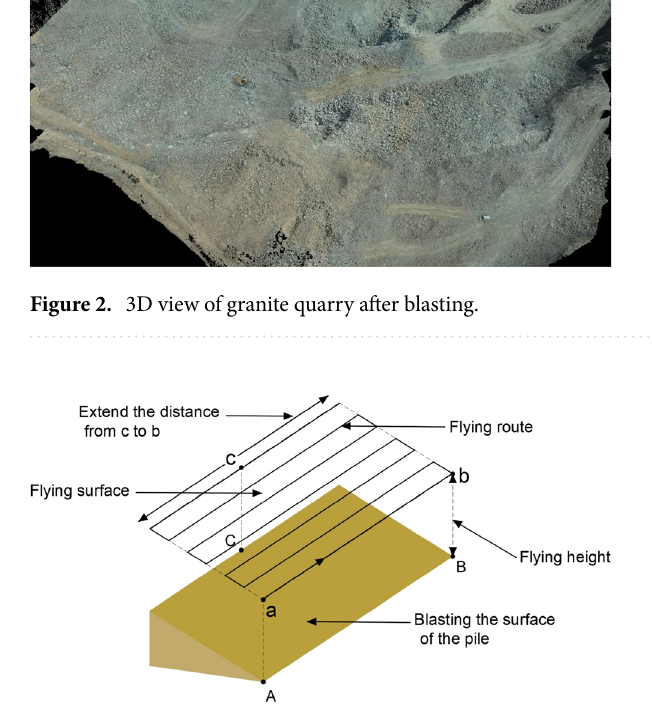
Figure 3. UAV flight